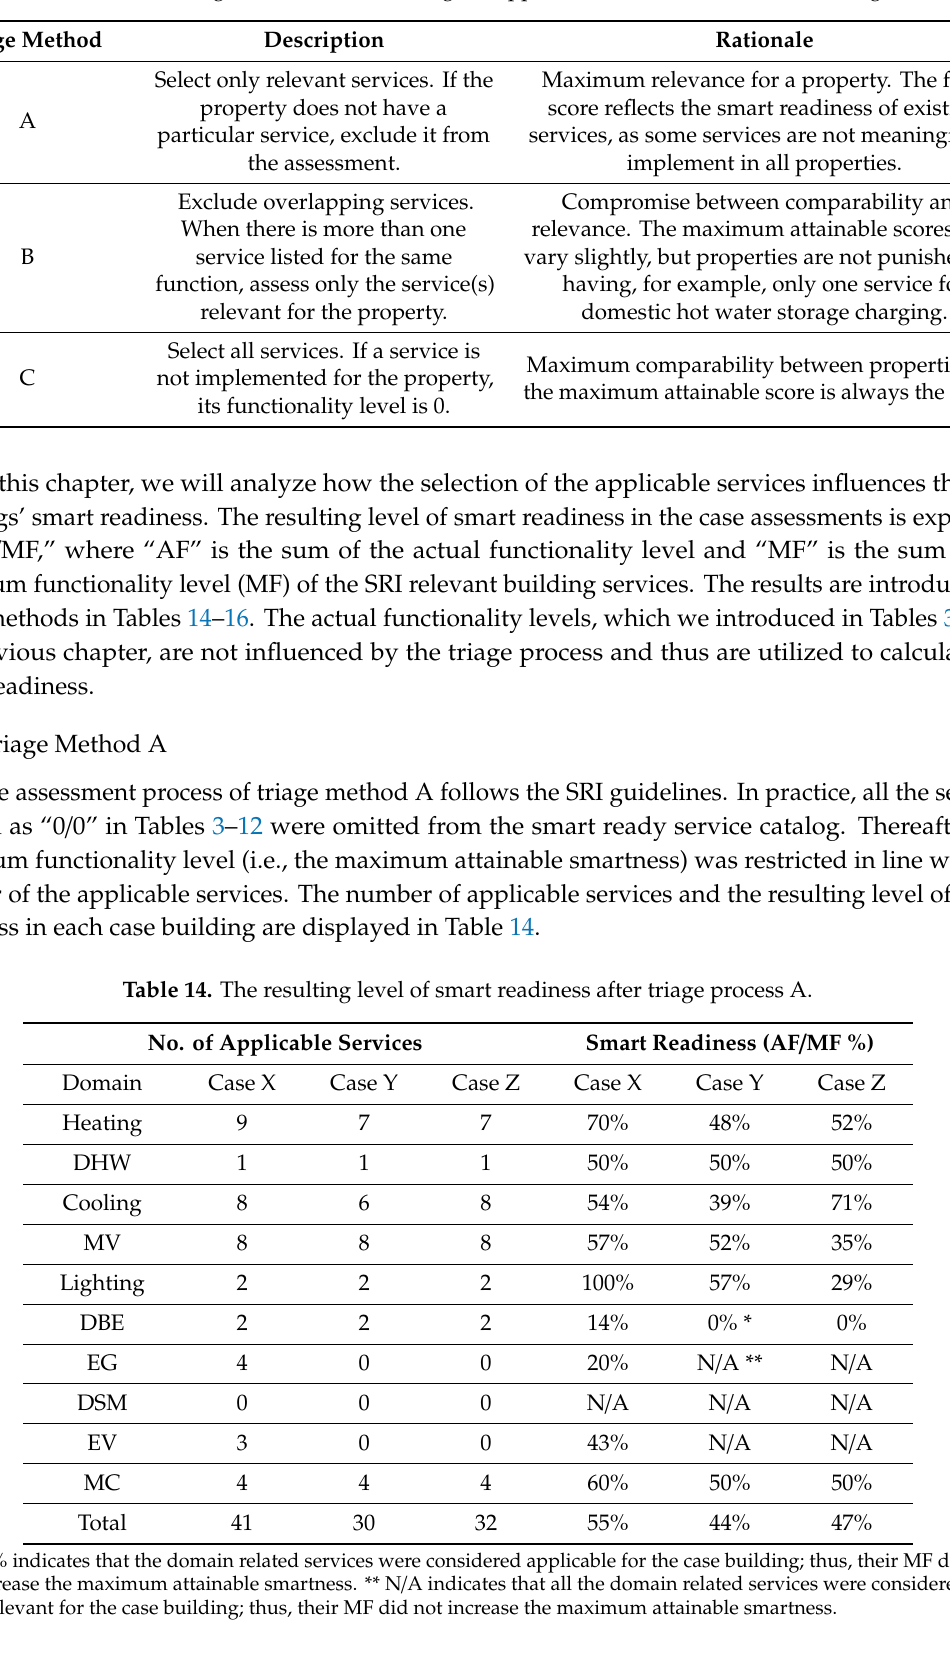
Table 13. The triage methods for selecting the applicable services in the case buildings.